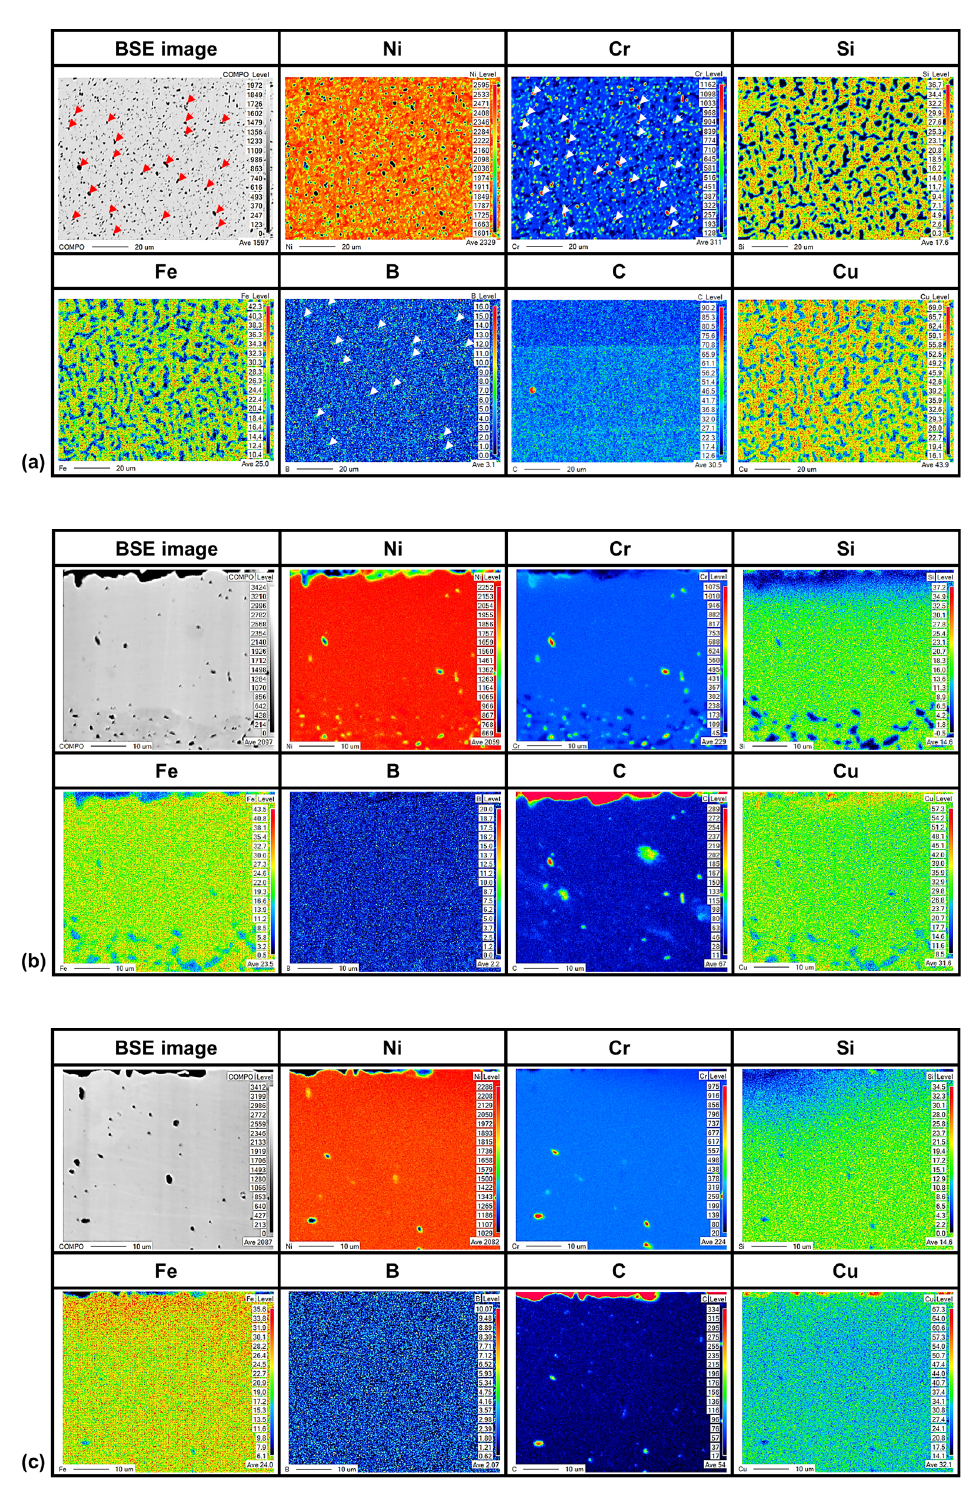
Figure 7. BSE images and elemental distribution maps determined using EPMA for clads near the surface, heat treated at: ( a ) 1073 K for 20 min, ( b ) 1223 K for 180 min, and ( c ) 1223 K for 500 min.